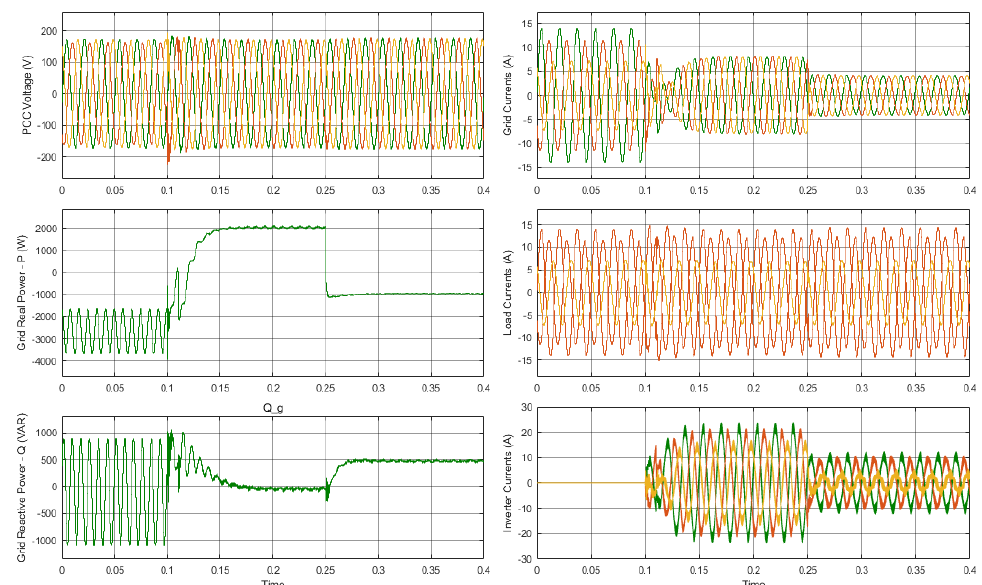
Figure 10. MATLAB/SIMULINK